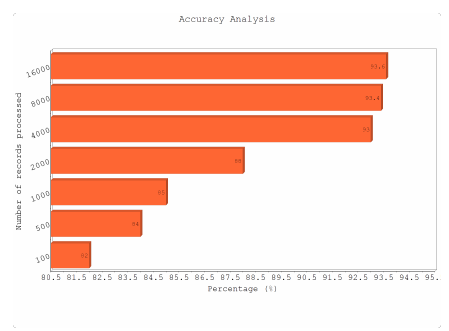
Figure 6. Accuracy Analysis of posposed ETL model while increasing number of records